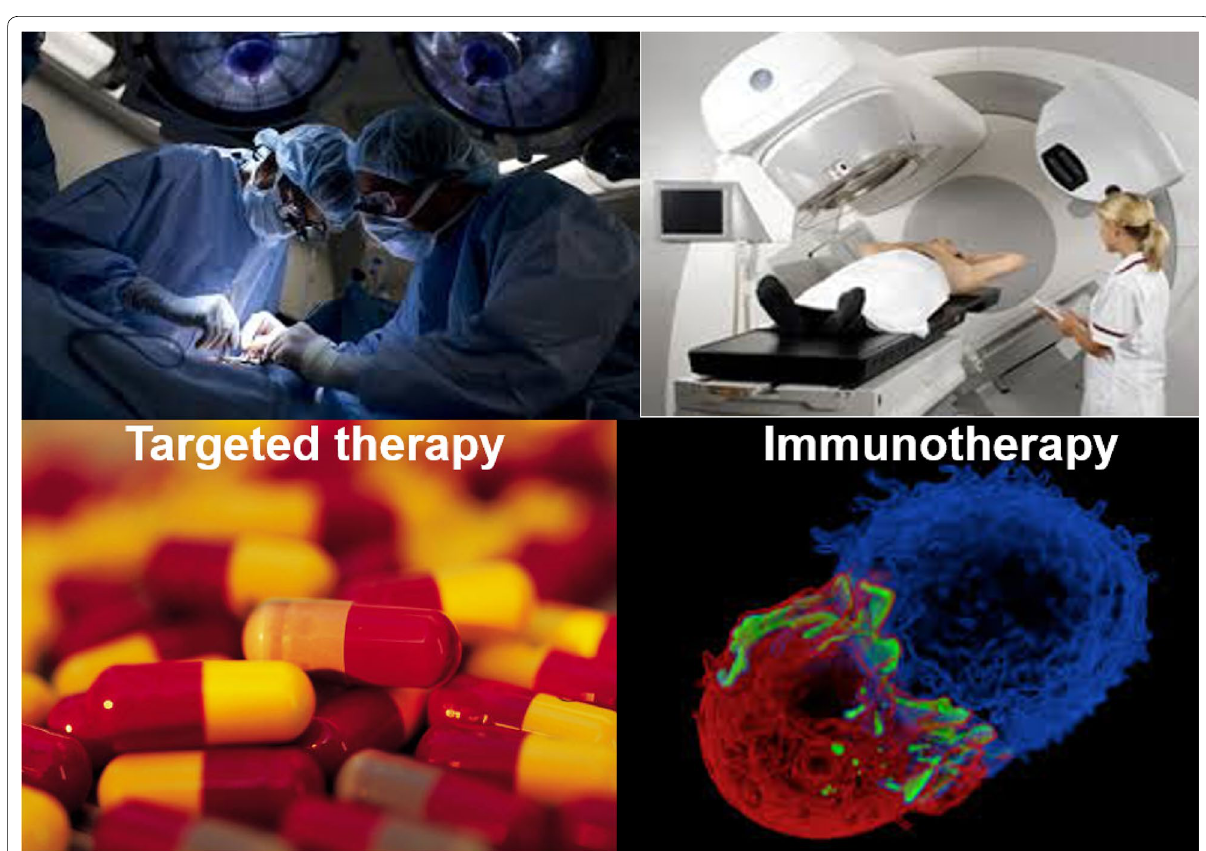
Fig. 1 Several types of treatment are used for melanoma patients; surgery, radiation, drug therapy, and immunotherapy. These treatments are often used in combination—especially for patients with metastatic